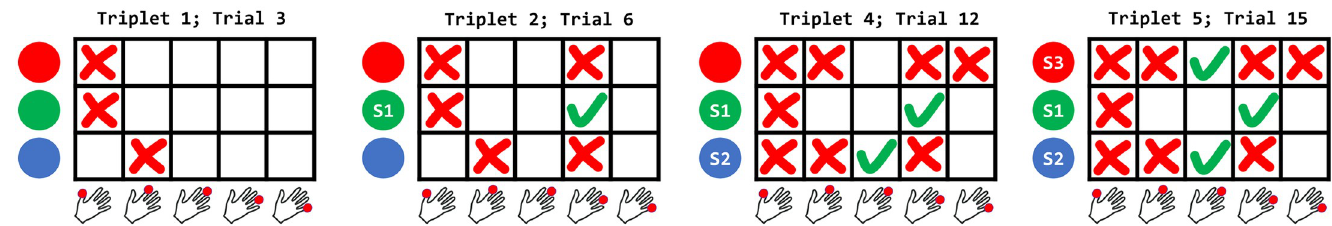
Fig 1. The visuomotor learning task used to validate the model. Three colour stimuli are presented to the participants in a pseudo-random order, in particular in triplets each containing each colour exactly once. The action consists in pressing one out of five possible buttons with the right hand. The figure refers to an ideal participant who never repeats an error for the same colour and always repeats the correct action after discovering it. The four pictures refer to respectively the actions after one, two, four, and five triplets: a red cross and a green tick-mark refer to incorrect and correct colour-action sequences respectively. The colour receiving the first action in the second triplet is marked as the ‘first stimulus’ (S1), and such action is considered the as correct one for it. The colour different from S1 receiving the first action in the fourth triplet is marked as the ‘second stimulus’ (S2), and such action is considered as the correct one for it. The colour different from S1 and S2 receiving the first action in the fifth triplet is marked as the ‘third stimulus’ (S3), and such action is considered the correct one for